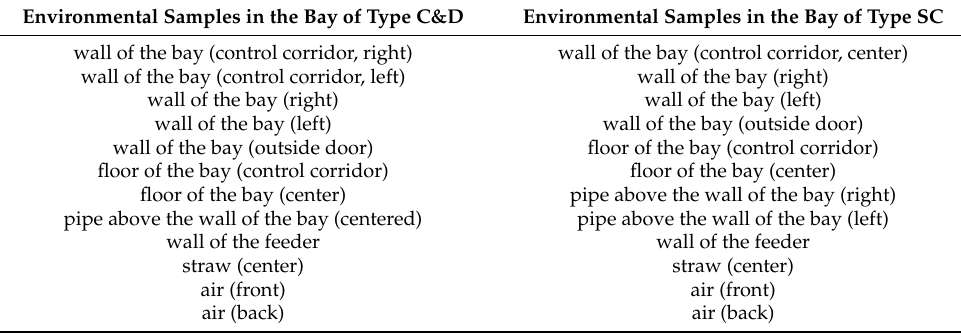
Figure 4. Schematic overview of the environmental sampling locations in the bay. Table 3. Overview of the environmental samples taken in type 1 and type 2.